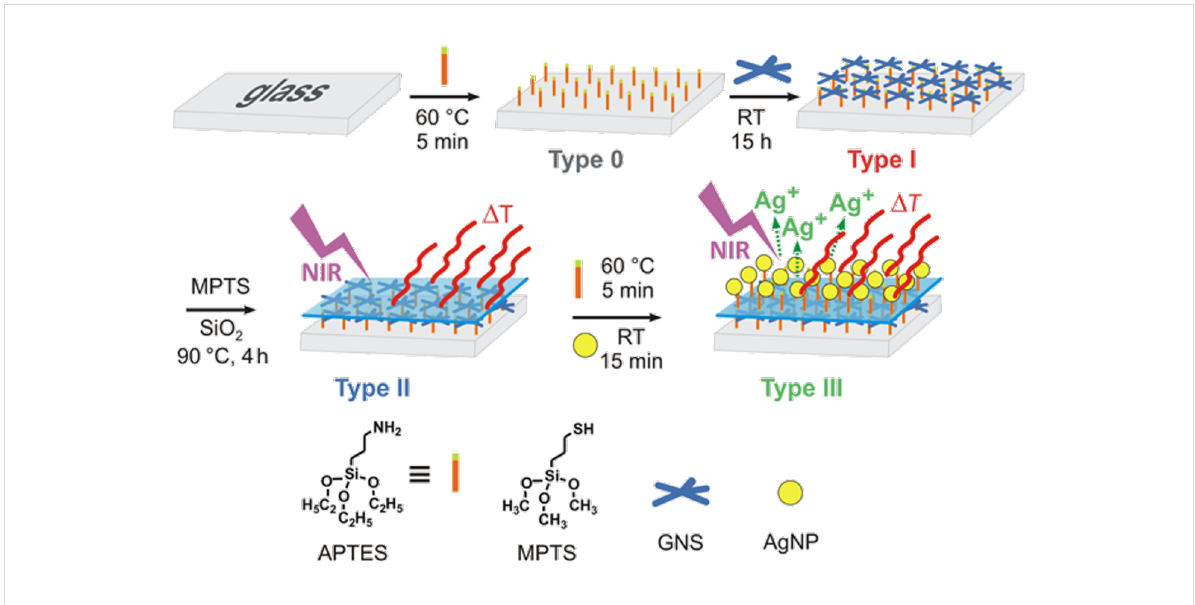
Figure 3: Preparation of a dual-function antibacterial surface with photo-switchable activity and sustained biocidal release. Figure reprinted with permission from [62], copyright 2017, under the terms of the Creative Commons CC BY License, http://creativecommons.org/licenses/by/4.0/.